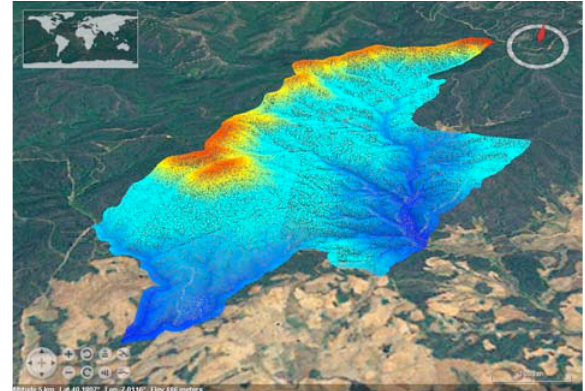
Figure 4 A LIDAR Point Cloud